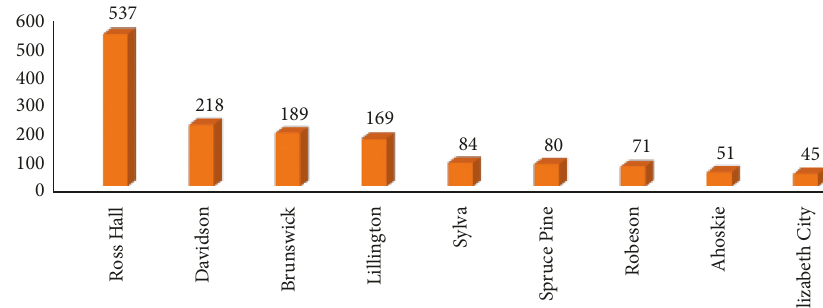
Figure 4: CBCT scans by the locations. The numbers on top of the bars represent the patient counts in each campus location.